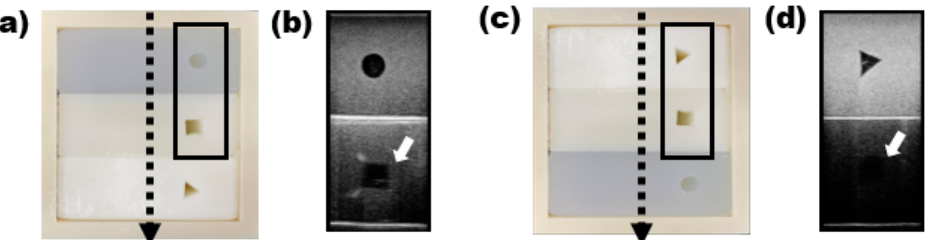
Figure 5. Image degradation by fat content. The black box shows the region of interest on the image. Ultrasound images ( b , d ) are the images corresponding to phantoms ( a , c ). Unlike image ( b ), the rectangular structure ( d ) is not visible in the ultrasound image because of the high fat content.